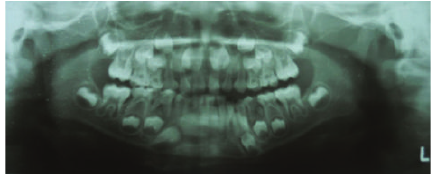
Figure 1: Preoperative OPG.